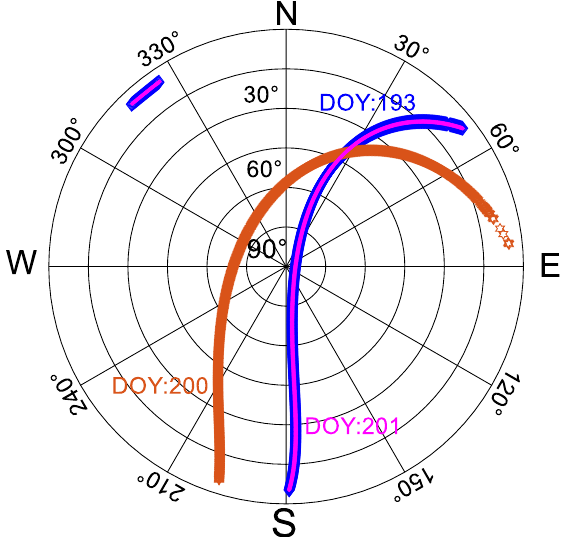
Figure 6. Skyplot of the GLONASS R14 satellite on DOY:193 (denoted by blue line), DOY:200 (denoted by brown line), and DOY:201 (denoted by pink line), 2021. The vertical means the elevation angle, and the circle represents the azimuth angle.